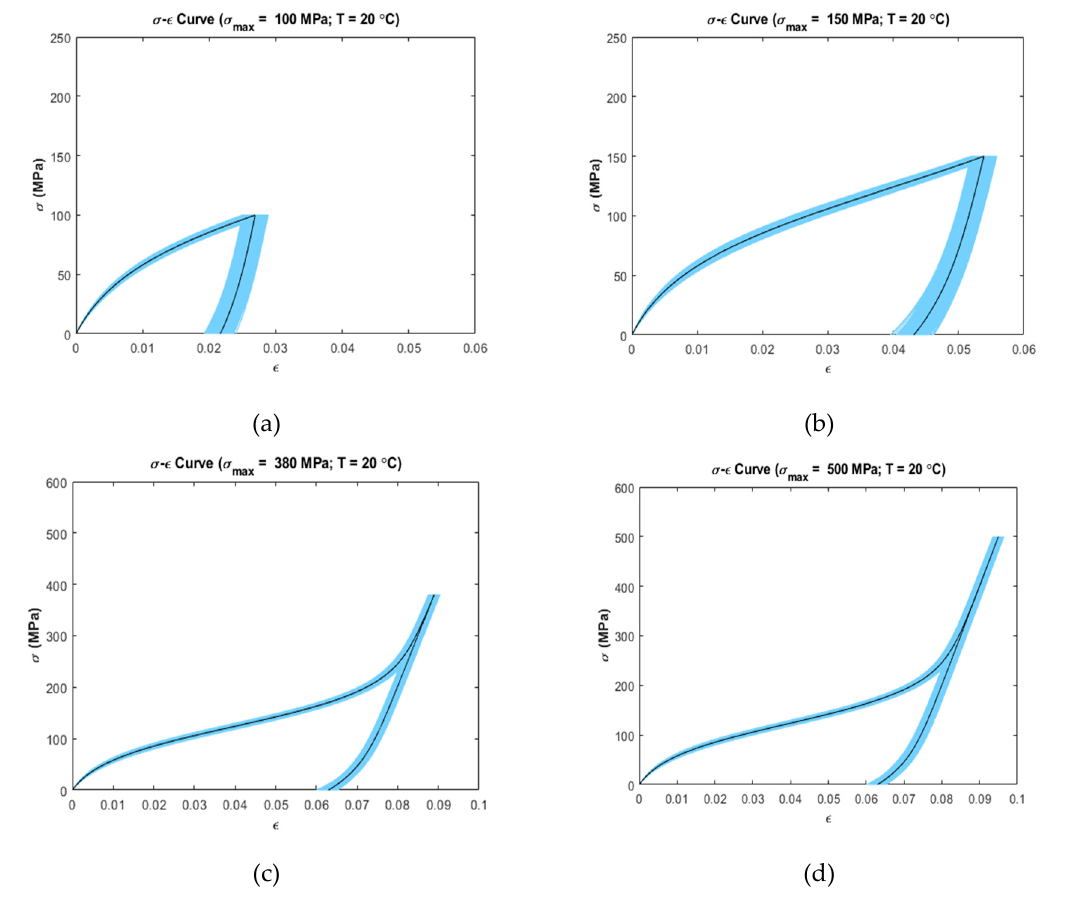
Figure 3. Confidence intervals (5–95 percentile) at simulated temperatures and maximum loading stress (Dark Color shows the deterministic curves); ( a ) T = 20 ◦ C, σ max = 100 MPa ( b ) T = 20 ◦ C, σ max = 150 MPa ( c ) T = 20 ◦ C, σ max = 380 MPa ( d ) T = 20 ◦ C, σ max = 500